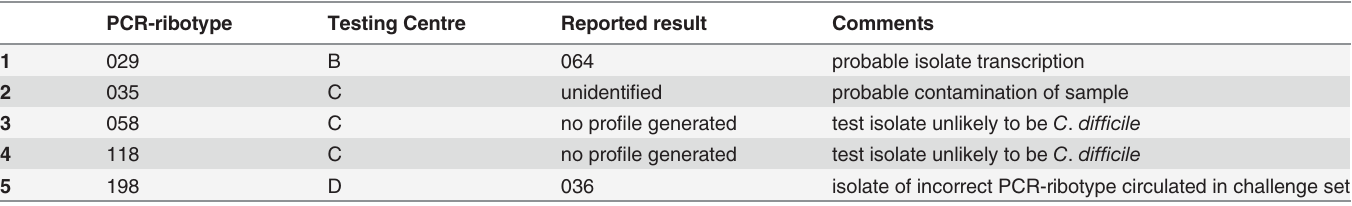
Only 5 identi fi cation failures were present in validation stage 2, and were not associated with any particular testing centre or any speci fi c PCR-ribotype. All failures highlighted errors associated with the manipulation of test isolates as opposed to inconsistencies with the prescribed method, or data